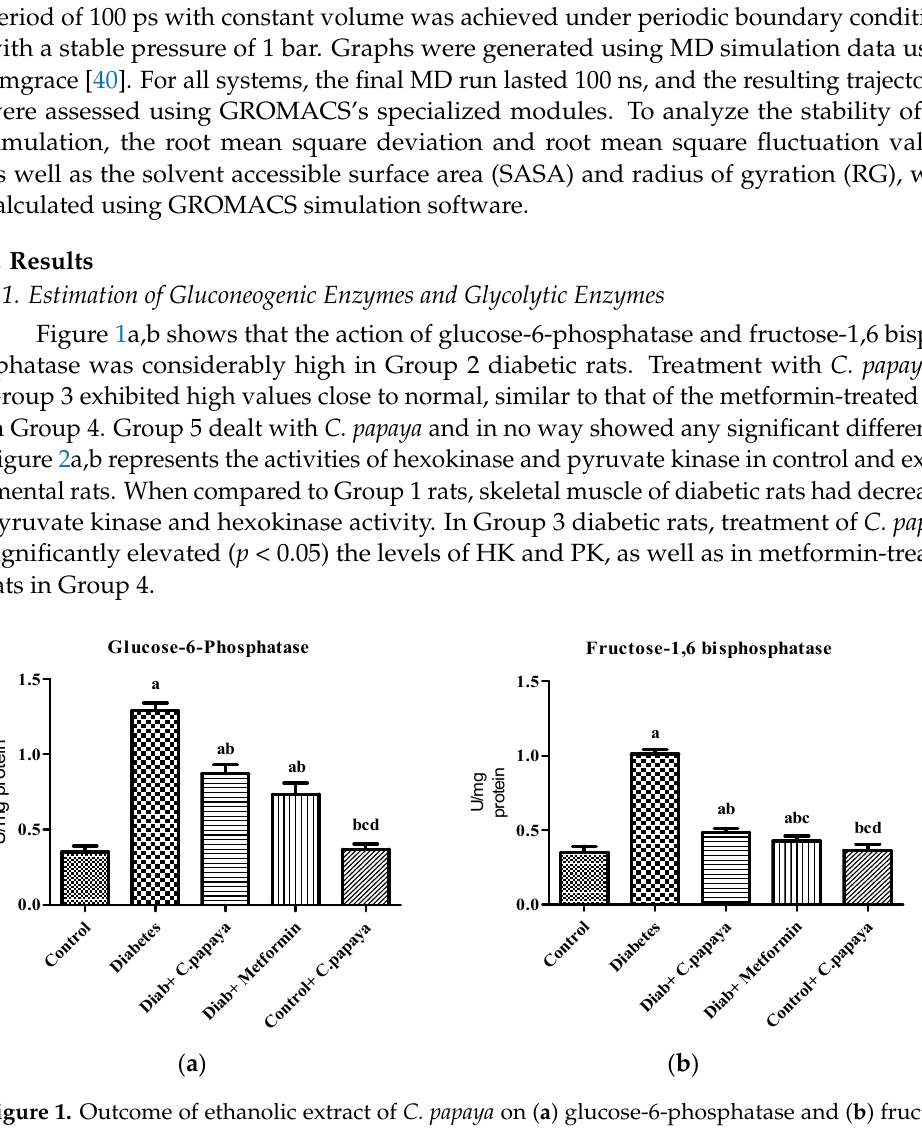
( b ) Figure 2. Outcome of ethanolic extract of C. papaya on ( a ) hexokinase and ( b ) pyruvate kinase levels in control and diabetic rats. Each bar illustrates the mean ± SEM of eight rats, with p < 0.05 demon- strating significant differences between the groups: a—control; b—diabetes; c—diabetic rats ad- ministered with ethanolic extract of C. papaya. 3.2. Effect of C. papaya on mRNA Expression of IRS-1 and Akt The effect of C. papaya on mRNA expression on IRS-1 in skeletal muscle of all the five groups in the experimental study is portrayed in Figure 3a. There was a substantial de- crease in the gene expression levels of IRS-1 in diabetic group rats. However, the treat- ment with C. papaya boosted IRS1 gene expression in skeletal muscle at par with the treatment of metformin. In skeletal muscle, Akt increased glycogen synthesis by activat- ing glycogen synthase. In this study, Group 2 skeletal muscle had greatly reduced Akt gene expression. Interestingly, C. papaya administration revoked the gene levels of Akt, as shown in Figure 3b, even in the metformin treatment. No major alterations in Akt levels were seen in Groups 1 and 5. These results infer the capability of C. papaya to escalate the signaling of insulin in skeletal muscle of diabetic animals.